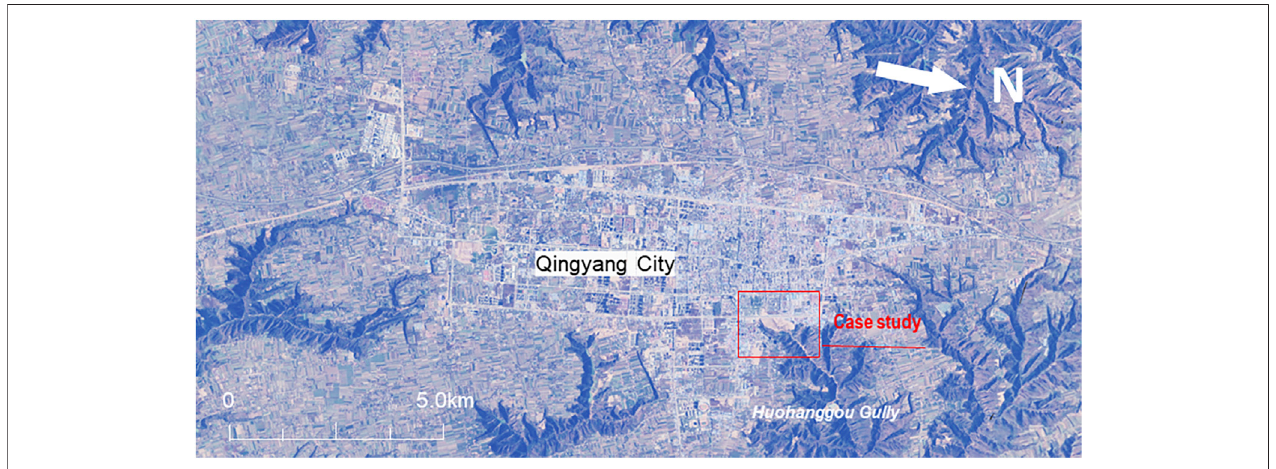
FIGURE 2 | Loess tableland of Dongzhiyuan eroded by